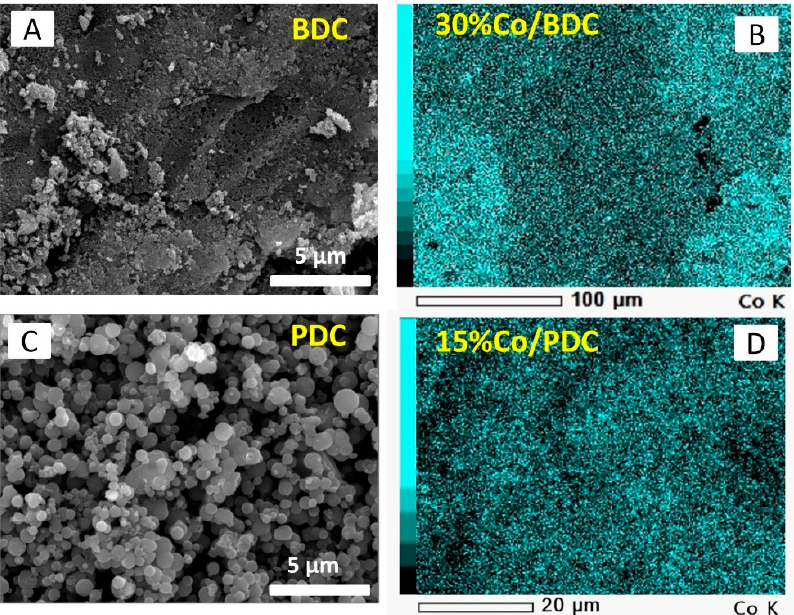
Figure 2. Scanning electron microscopy (SEM) micrographs of carbon supports ( A ) and ( C ) and their respective cobalt oxide-impregnated carbon materials ( B ) and ( D ).